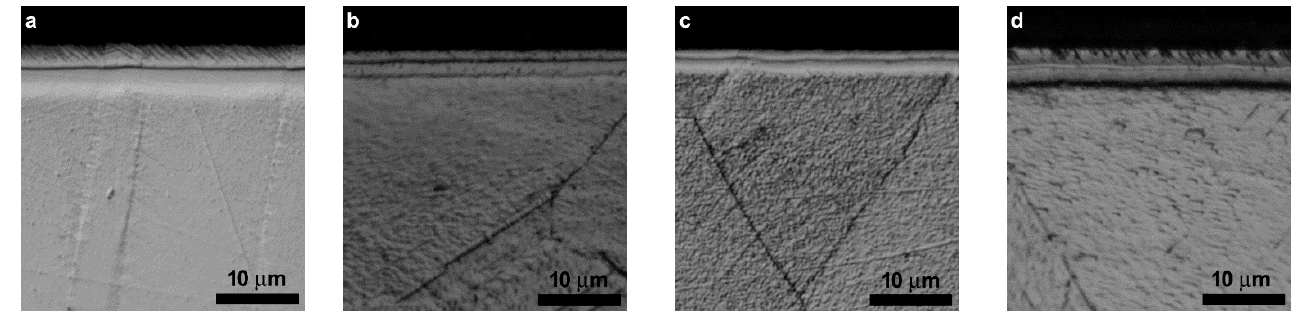
Figure 2. Micrographs of the modified surface layers of samples nitrided at 380 °C, 3 h, 50 vol.% N 2 + 50 vol.% H 2 ( a ), at 360 °C, 50 vol.% N 2 + 50 vol.% H 2 , for 1 ( b ), 3 ( c ), and 5 ( d ) h. (Cross-section; etchant: acetic glyceregia).